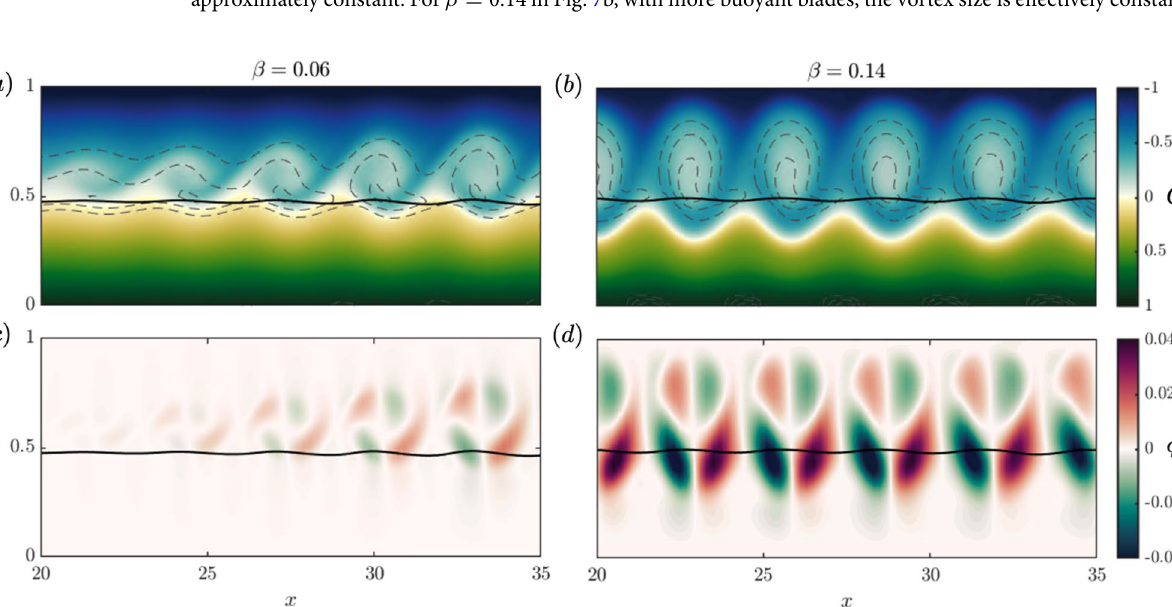
Figure 7. Vortex size and tracer transport variability for β = 0.06 and 0.14. Instantaneous plots of ( a , b ) the tracer concentration C , with gray dashed lines representing iso-vorticity contours ( ζ = 1.5, 2, 2.5 ), and ( c , d ) vertical tracer flux φ , at t = 500 , with Re = 1000 and β = 0.06 and β = 0.14 , respectively. The solid black line is the seagrass height h g